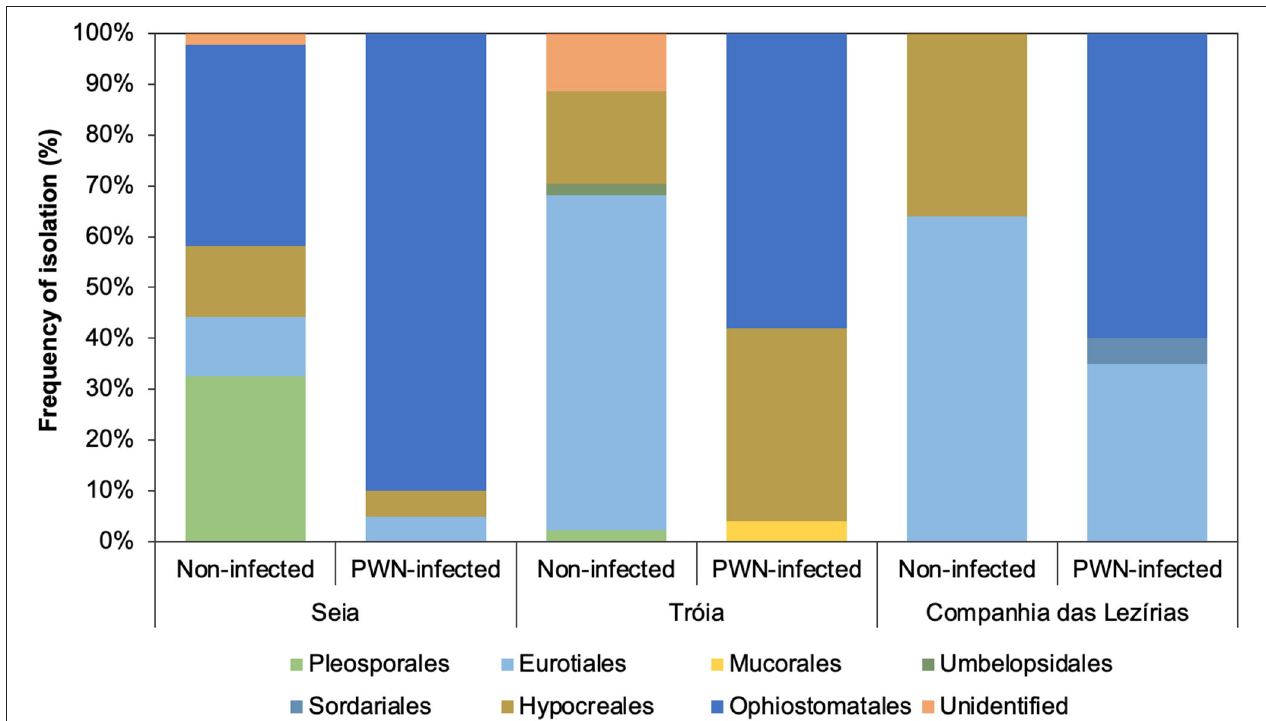
FIGURE 1 | Frequency of isolation (%) of the main Ophiostomatales orders isolated in this study.